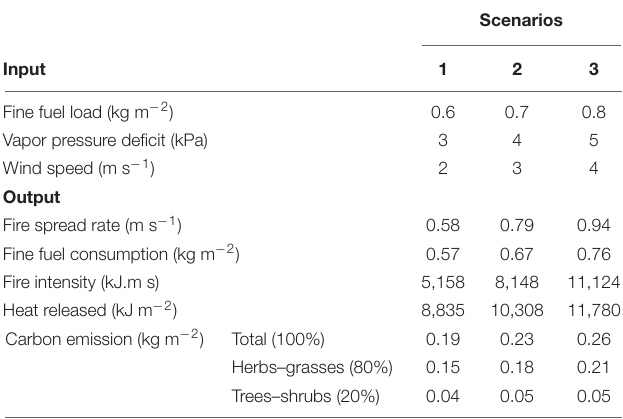
TABLE 2 | Fire behavior and carbon emission simulations for the Brazilian savanna using the BEFIRE model with three scenarios (inputs: 1 moderate, 2 medium, 3 extreme) for fine fuel and